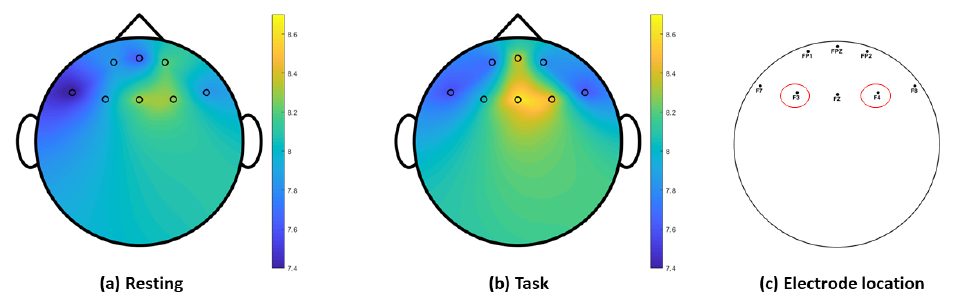
Figure 4. Brain topography of relative alpha power during ( a ) resting and ( b ) task conditions, and ( c ) location of electrode pair with alpha asymmetry index correlated with resilience